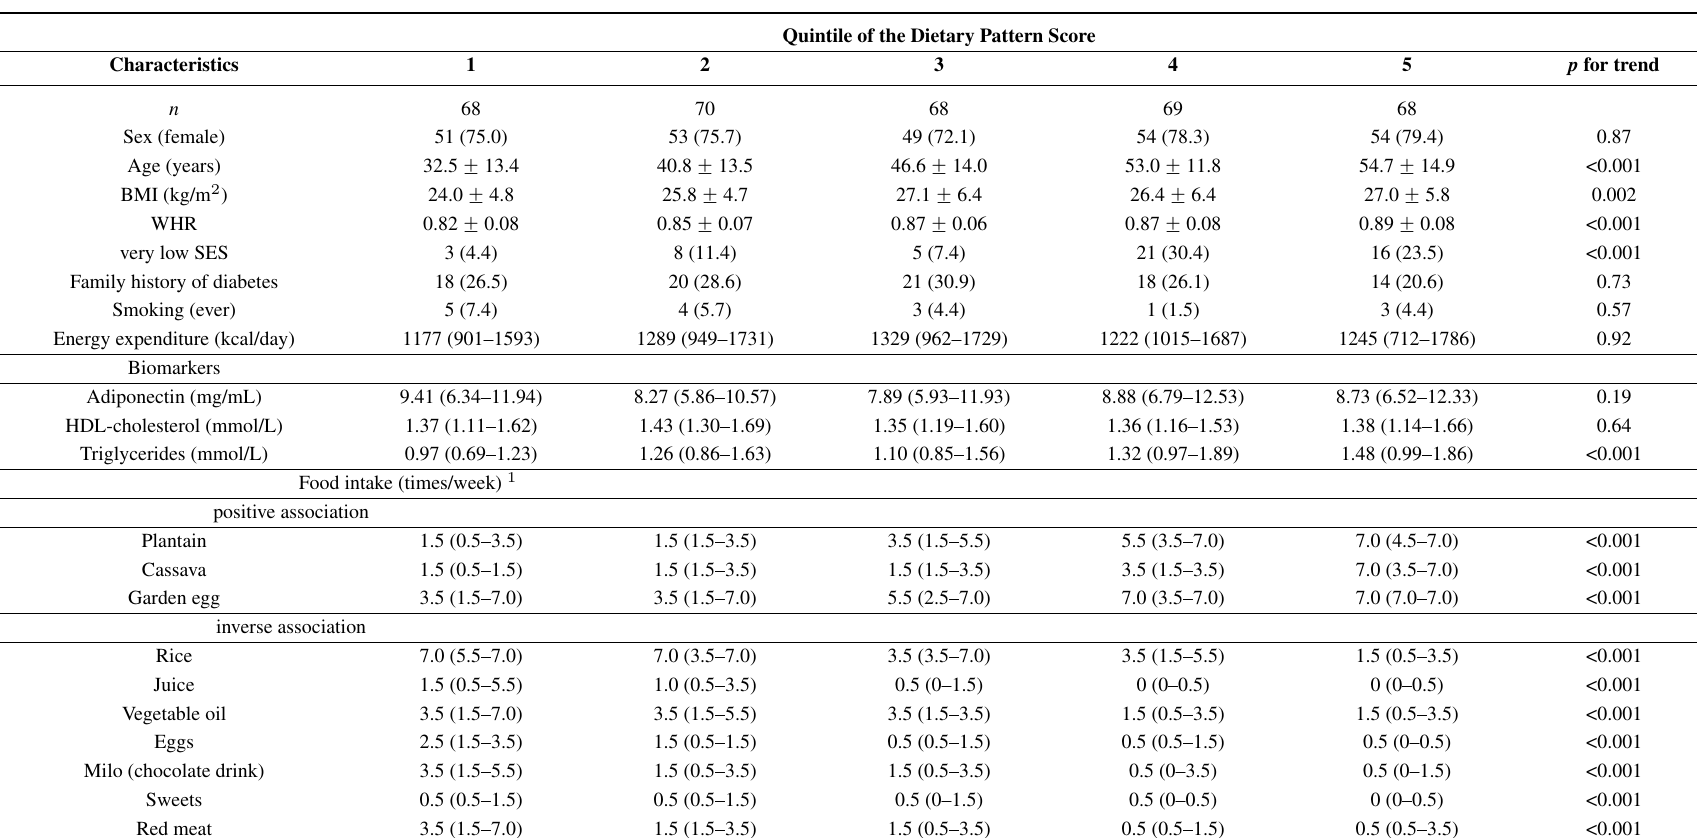
Table 3. Characteristics and biomarkers by quintiles of dietary pattern score among 343 controls in the validation set. Quintile of the Dietary Pattern